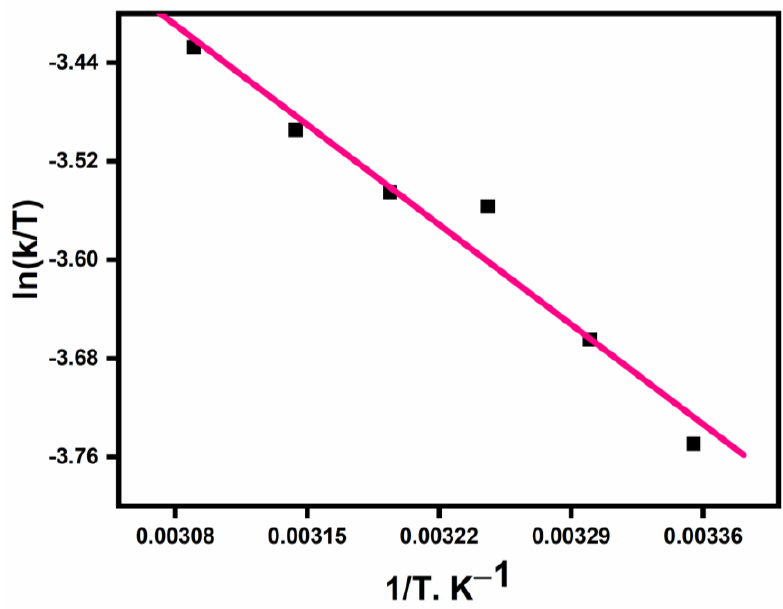
Figure 4. Eyring plot for cis-[Co(ip) 2 (C 12 H 25 NH 2 ) 2 ](ClO 4 ) 3 in [BMIM]Br medium. [Complex] = 4 × 10 − 4 mol dm − 3 ; [Fe(CN) 6 ] 4 − = 0.01 mol dm − 3 ; [ µ ] = 1.0 mol dm − 3 .